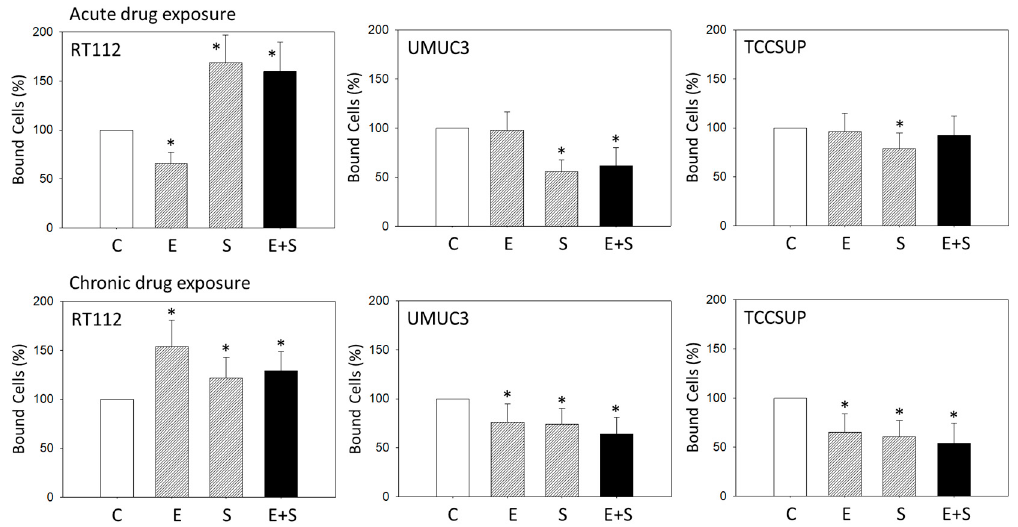
Figure 1. Adhesion of RT112, UMUC3, and TCCSUP cells exposed to 0.5 nM everolimus (E), 2.5 µM sulforaphane (S), or 0.5 nM everolimus + 2.5 µM sulforaphane (E + S). Control cells (C) remained unexposed (set to 100%). Mean number of adherent tumor cells from five fields after 1 h incubation. Bars indicate standard deviation, * indicates significant difference to corresponding control, p ≤ 0.05. n = 5.